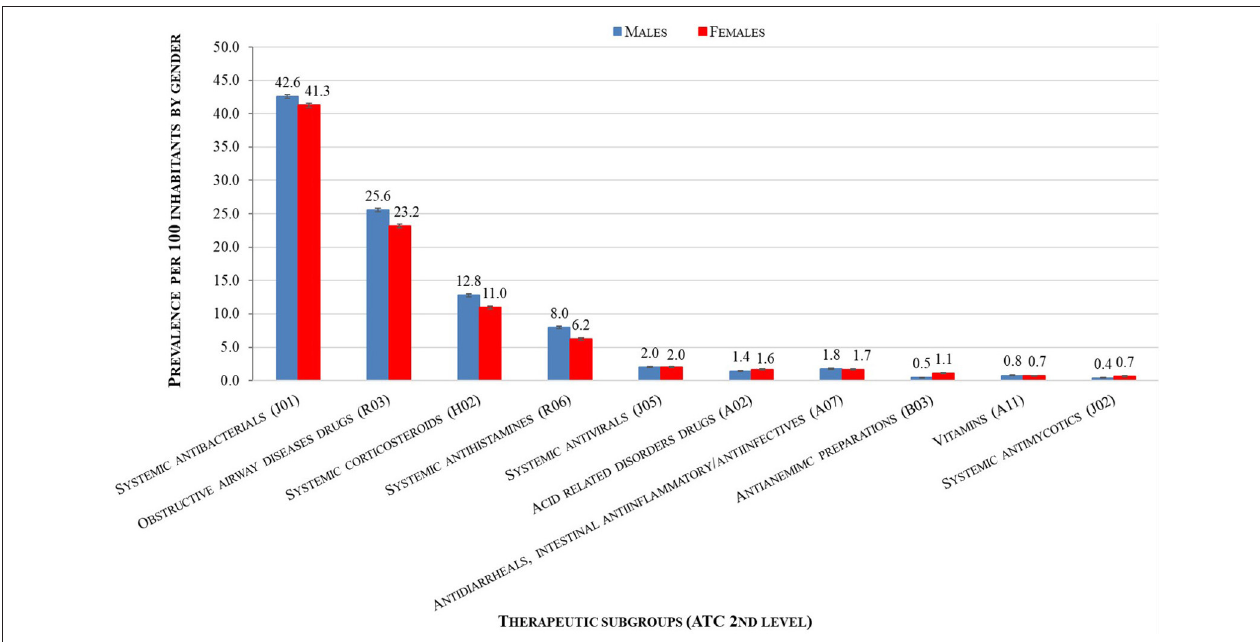
FIGURE 2 | Gender distribution of the prevalence per 100 children of use of most commonly used drug classes in 2015 at therapeutic subgroups (2nd level of